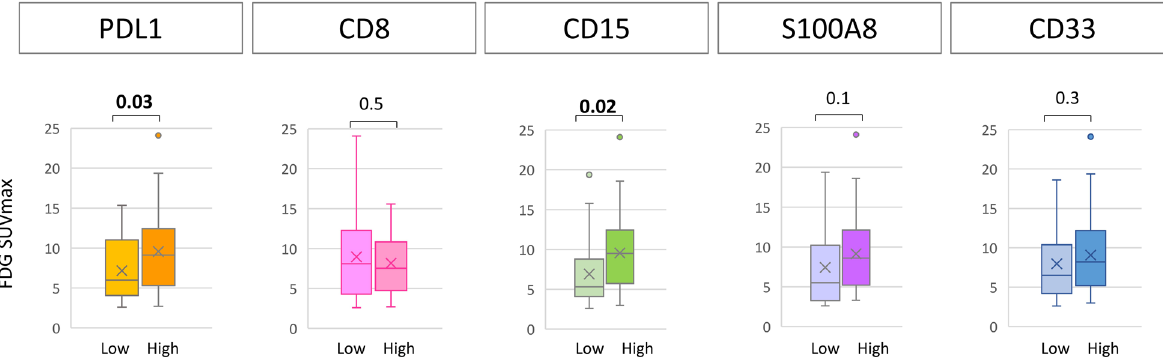
Fig. 4 Box-and-whisker diagrams show the distribution of the maximum standardized uptake value (SUVmax) in the high and low groups of programmed death ligand-1 (PD-L1) expression and CD8 + , CD15 + , S100A8 + and CD33 + cell counts. Significantly higher SUVmax, denoting higher fluoro- d -glucose uptake, was found in patients with PD-L1 expression group and in those with high CD15 + cell counts ( P respectively). There was no significant difference in SUVmax with respect to the number of CD8 + , S100A8 + , or CD33 +